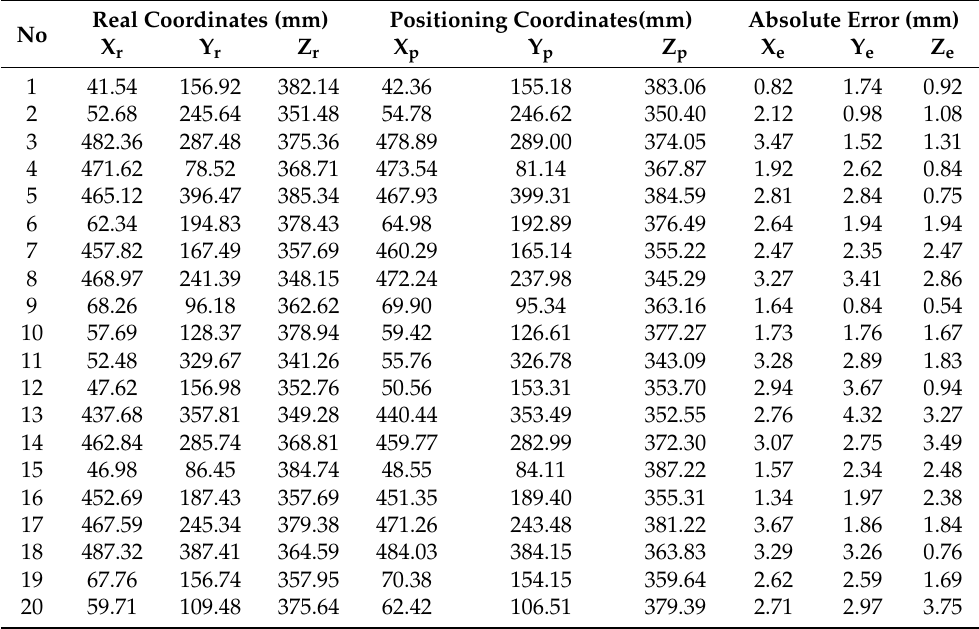
Table 11. The spatial positioning experiment results of